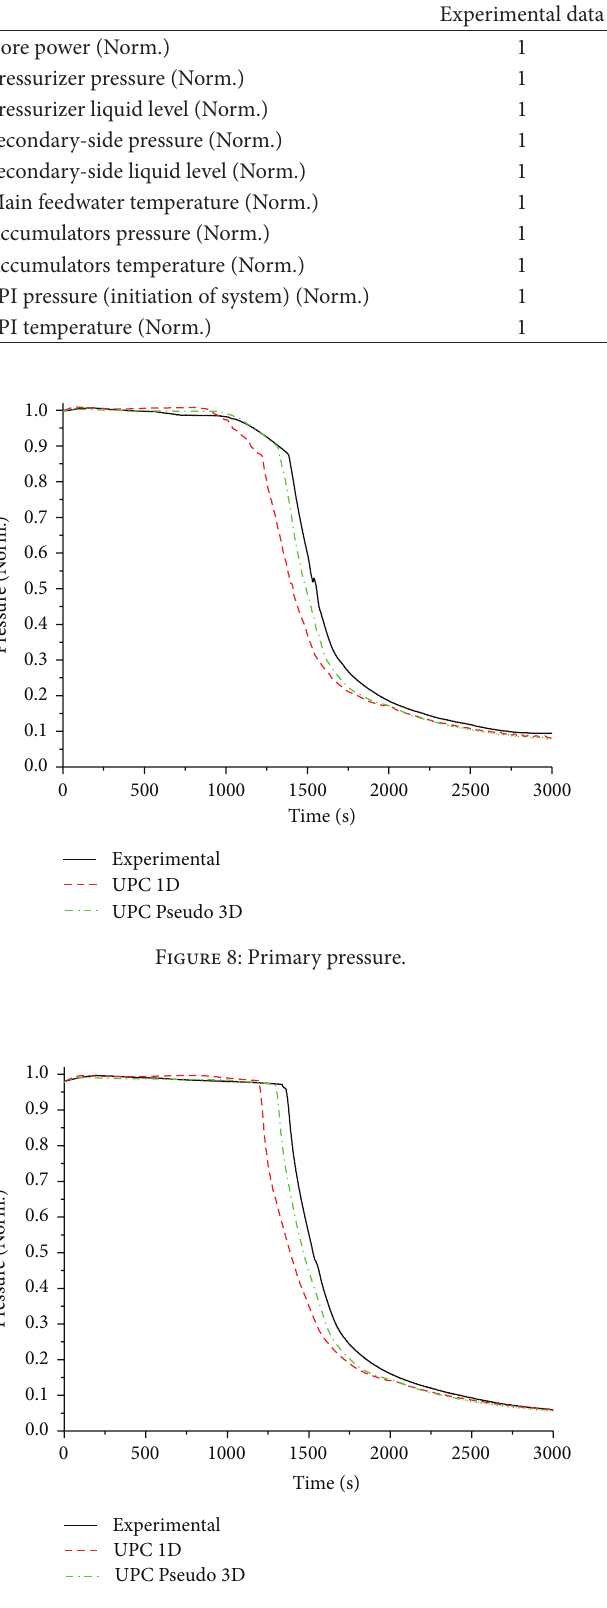
Figure 9: Secondary pressure.